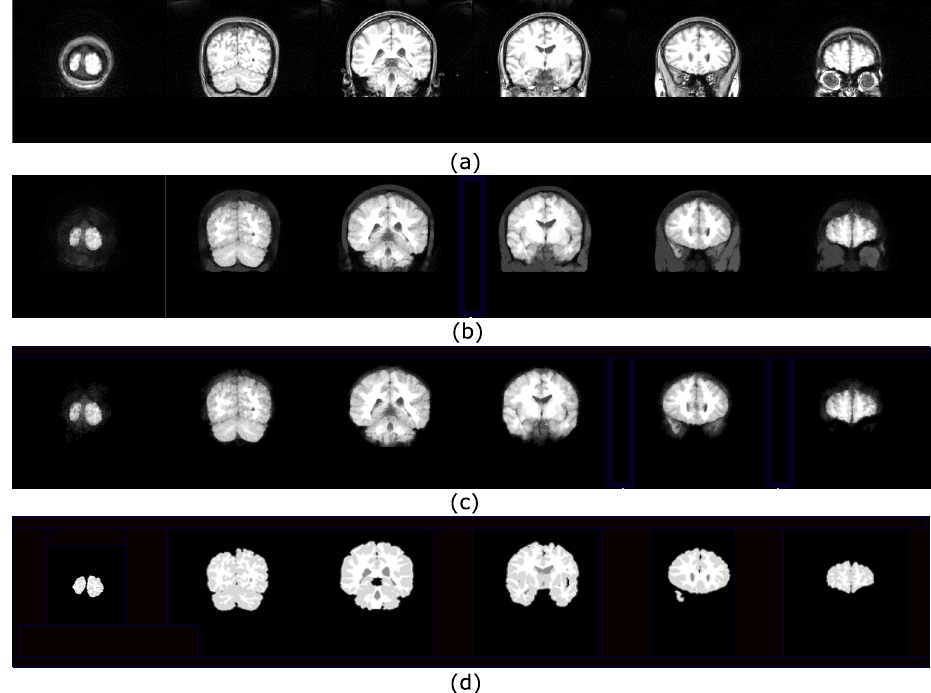
Figure 10. Set of images processed using the HLL procedure presented in Figure 9: ( a ) Input images; ( b ) viscous components obtained from step (3) using α = 3, λ = 3 and the greater volume computed from a max-tree branch; ( c ) brain segmentation after applying the Otsu threshold; ( d ) ground truth images obtained from the IBSR repository.